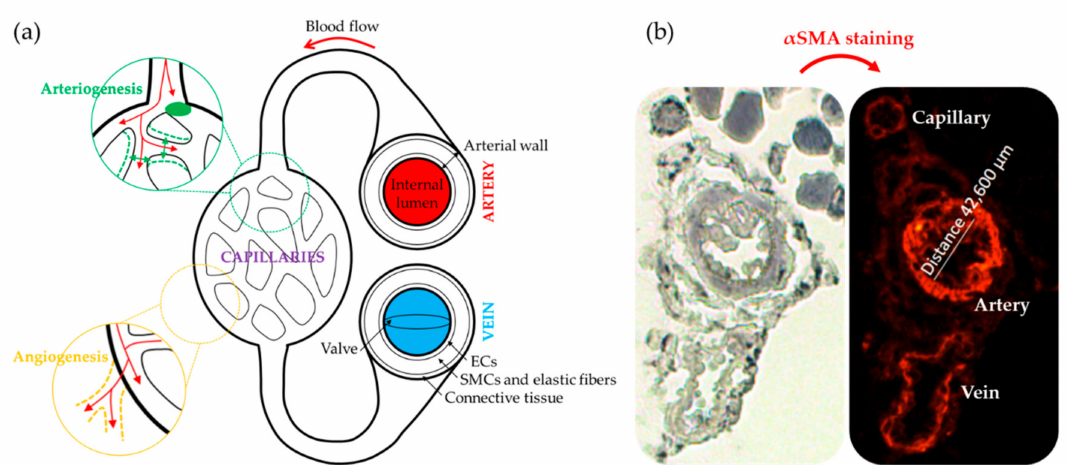
Figure 3. Mechanisms of neovascularization. ( a ) Schematic representation of the circulatory system in which angiogenesis and arteriogenesis processes are represented. ( b ) Representative immunohistochemistry image of blood vessels detected in the low back muscle of a CLI mouse [47], to evaluate vascular density and diameter size using anti-smooth muscle α -actin ( α -SMA, red)